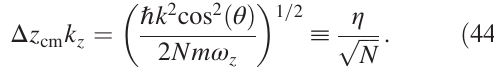
versus velocity and voltage for 7 Li þ ions with f app ;s